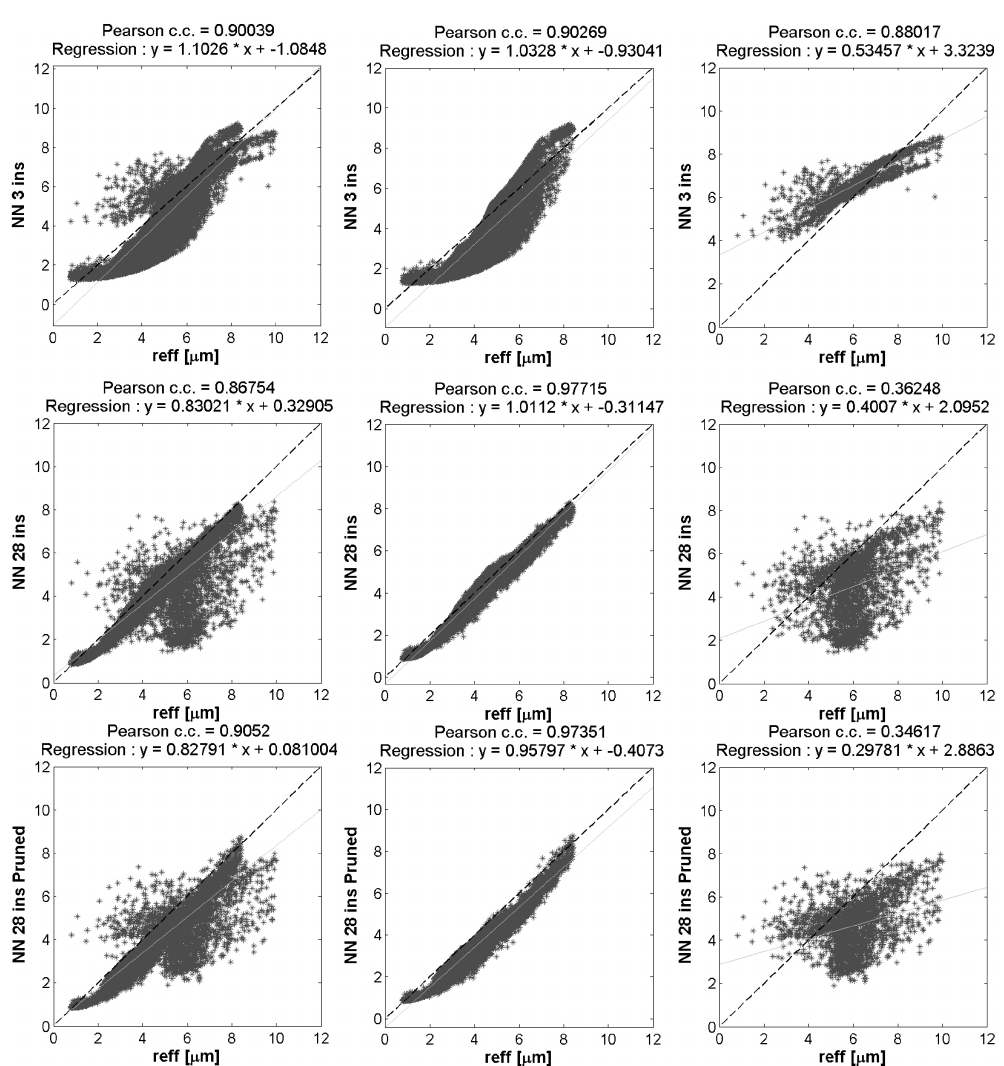
Figure 8. Scatterplots for r eff networks, 3 inputs (top row), 28 inputs (middle row) and 28 inputs pruned (bottom row), applied to the validation set of 11 May 2010, 14:05UTC, divided into total patterns (left column), patterns over sea (middle column) and patterns over meteorological clouds (right